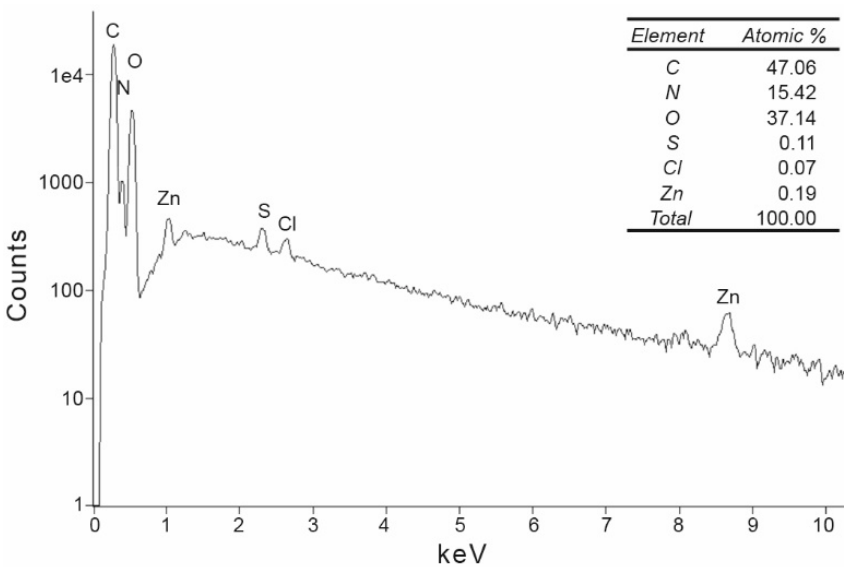
Figure 5. Energy-dispersive X-ray analysis (EDX) pattern of a silk film cast from silk fibroin dis- solved in ZnCl 2 and desalted by gel filtration. Data was recorded using an area analysis with a measuring area of 1 mm 2 . The inserted table presents the atomic percentage of the detected